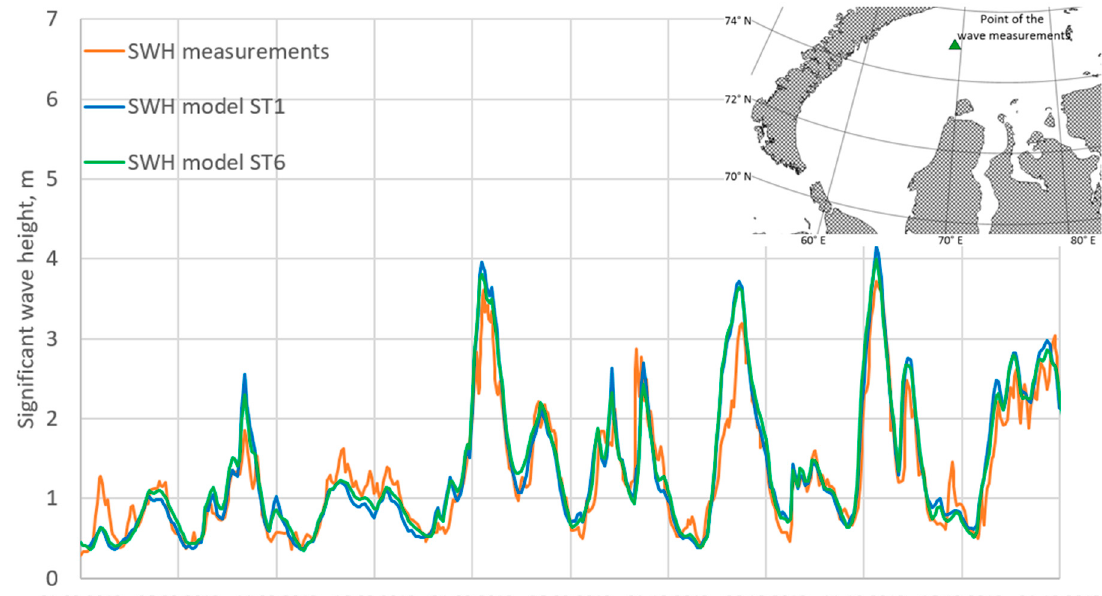
Figure 2. The measured and simulated significant wave height (SWH) for mooring station in the Kara Sea, location of the wave measurement station marked on insert map.